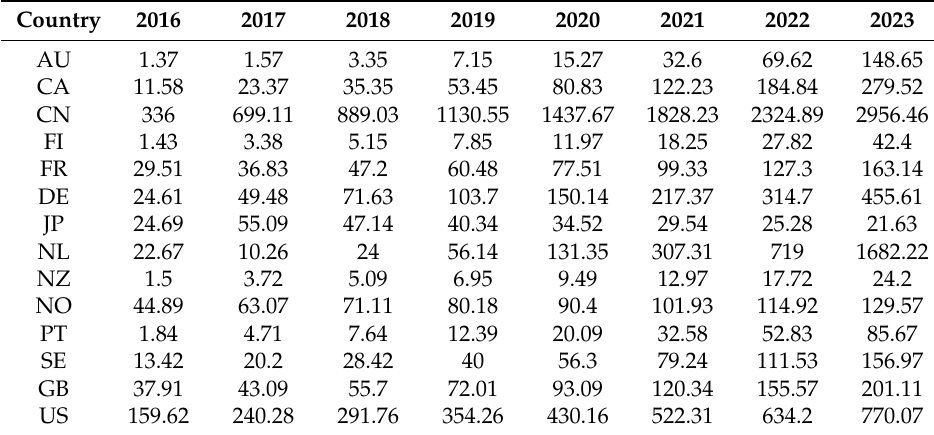
Table 6. The forecasted values of ECS.